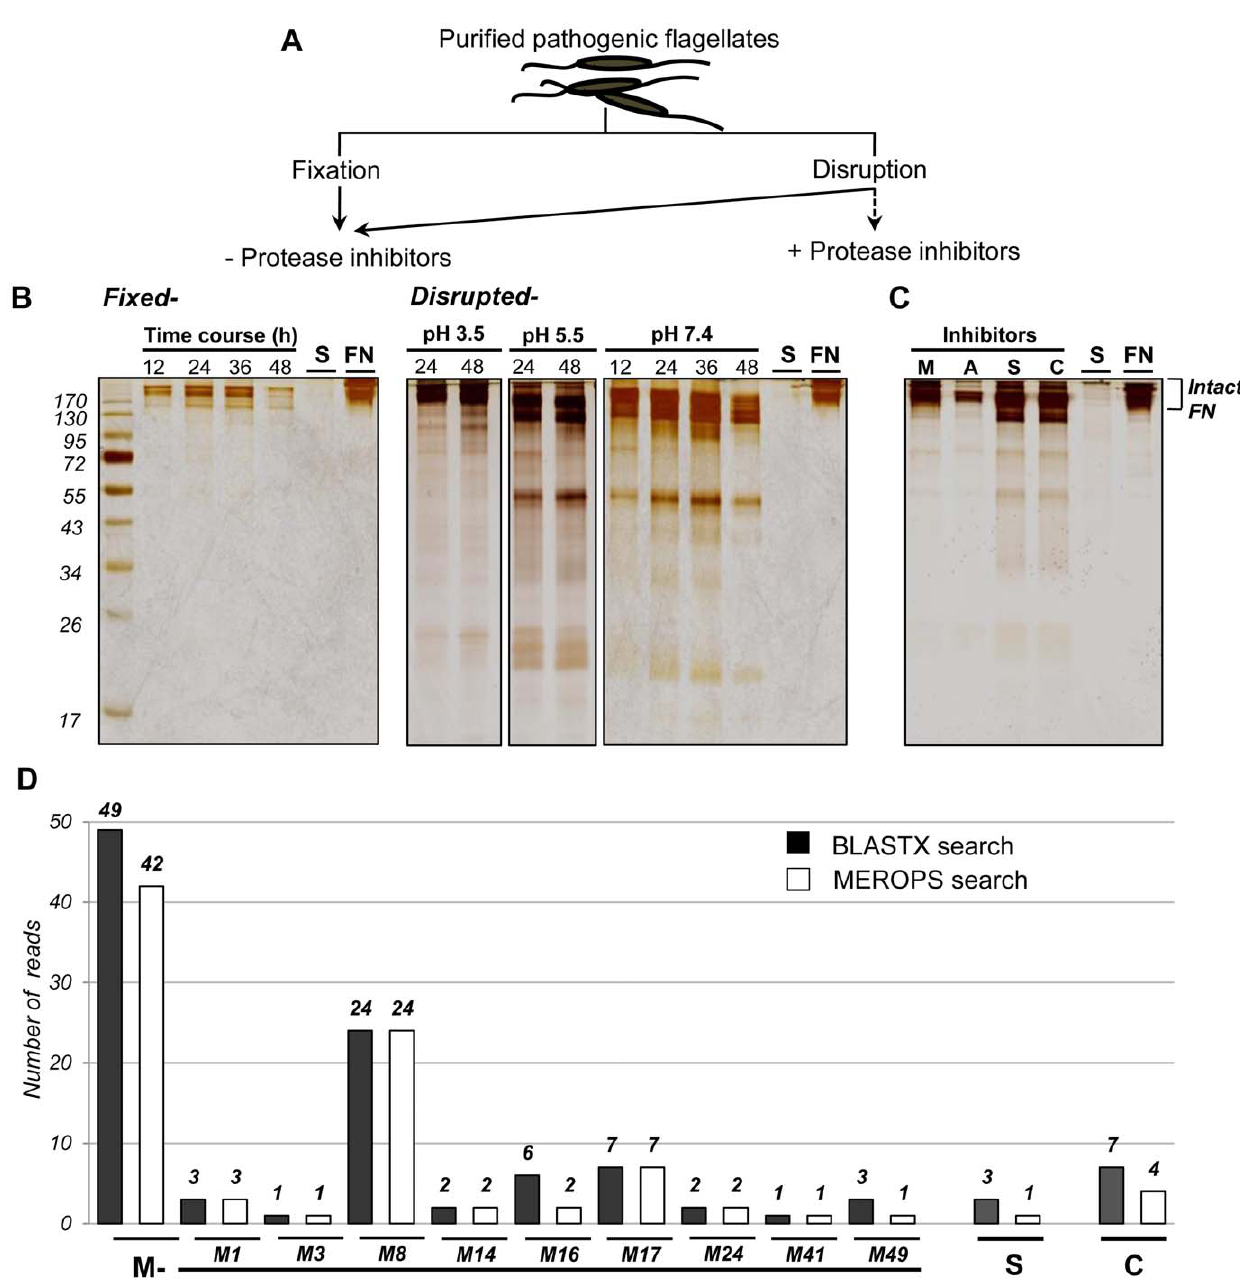
Figure 4. Assay of protease activity and effects of inhibitors. (A) Schematic representation of protease activity and inhibition assay. Samples were thawed and the purified pathogenic flagellates were transferred to PBS (pH 7.4) using tangential flow filtration, lysed with the same volume of 1% Triton X-100, lightly fixed with 0.5% glutaraldehyde, and incubated for 48 h with fibronectin (FN) at pH 3.5, 5.5, and 7.4. Substrate degradation was assessed by SDS-PAGE on 12.5% gels. Intact FN alone (FN) and the supernatant of a pooled sample containing purified flagellates (S) were used as controls. (B) Several degraded products ( , 170 kDa) of FN are detectable at various times (12, 24, 36, and 48 h) and pH (3.5, 5.5, and 7.4) in the disrupted group (right panel) but not in the fixed group (left panel). Numbers on the left are molecular weight markers. (C) EDTA, pepstatin, PMSF, and leupeptin were used as inhibitors of metallo- (M), aspartic- (A), serine- (S), and cysteine- (C) proteases, respectively, to identify the proteases related to fibronectinolysis. Inhibitory activity was assessed by SDS-PAGE on 12.5% gels. (D) The number of expressed transcripts (contigs) showing homology to the respective proteases and the putative metalloprotease homologs are shown. Black bars represent the homologues that have been identified using BLASTX search and white bars for the homologues, based on MEROPS search. (Figure 3B and Table 3). 20 sequences encoded two or three single most abundant hit was to family M8 of leishmanolysin-like peptidase (KOG2556); 24 homologs belonged to this family conserved amino acid residues of functional importance in either (Figure 4D), and showed crossover functions of cell wall/ zinc-binding motif (HExxH) and/or the second domain that membrane/envelope biogenesis and defense mechanisms determines the structural features of the module (Table S4).